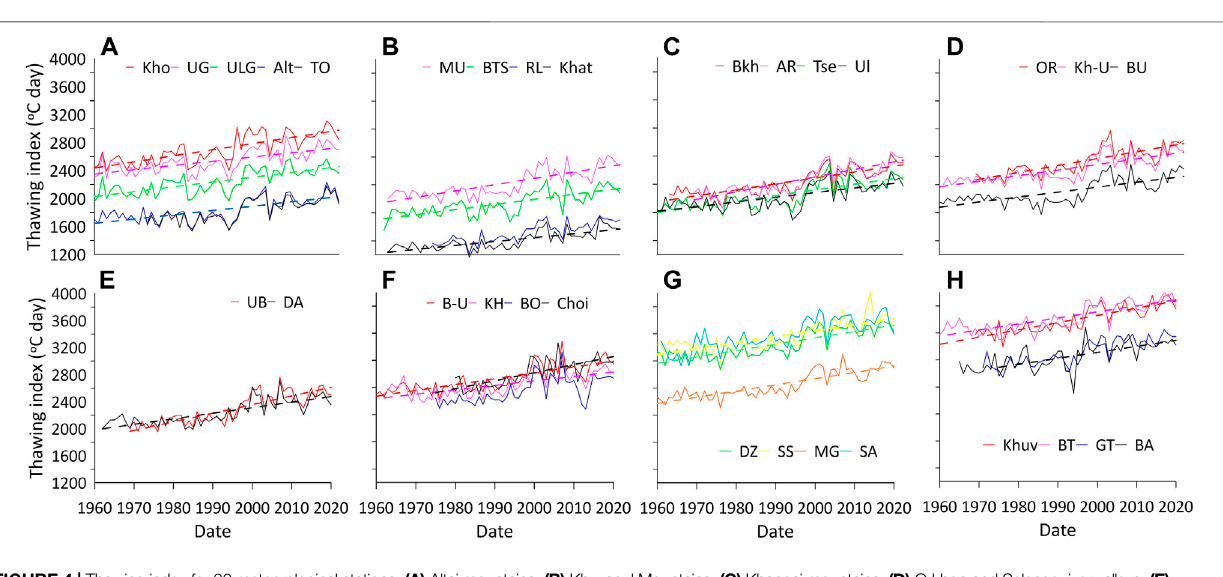
Frontiers in Earth Science |